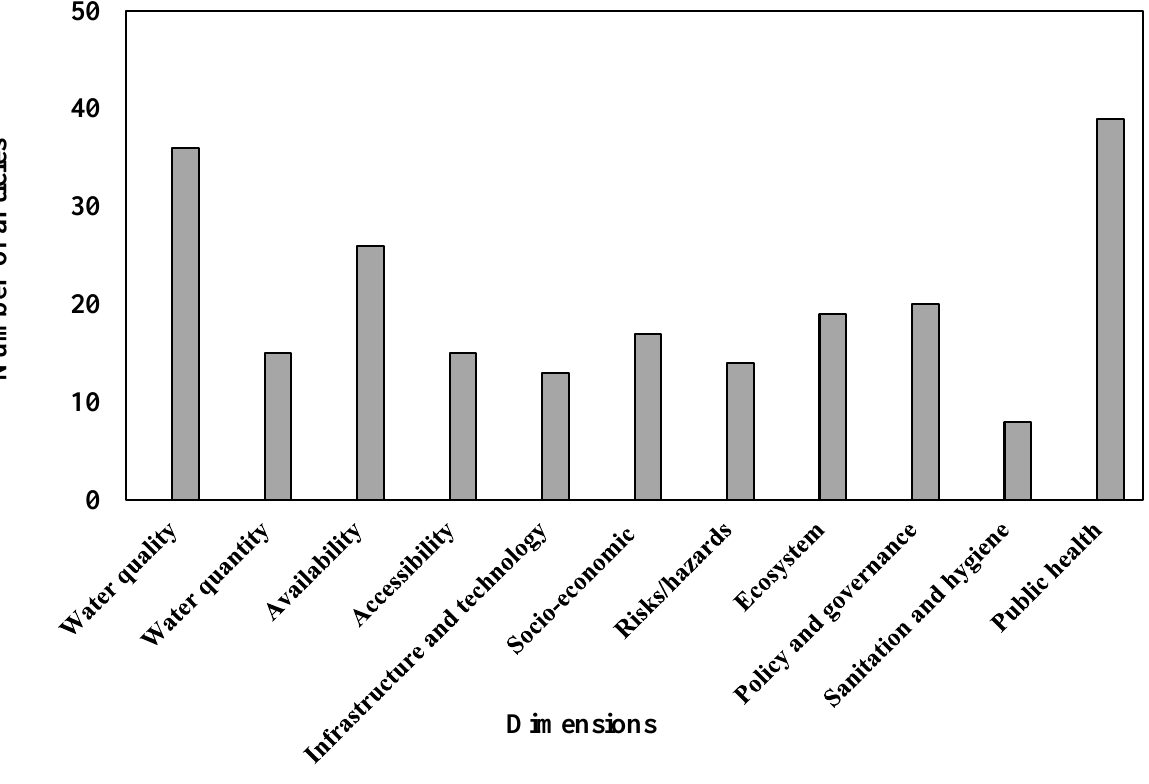
Figure 6. Summary of different water security dimensions.